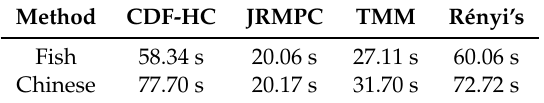
Table 3. Runtime of groupwise point set registration algorithms on different